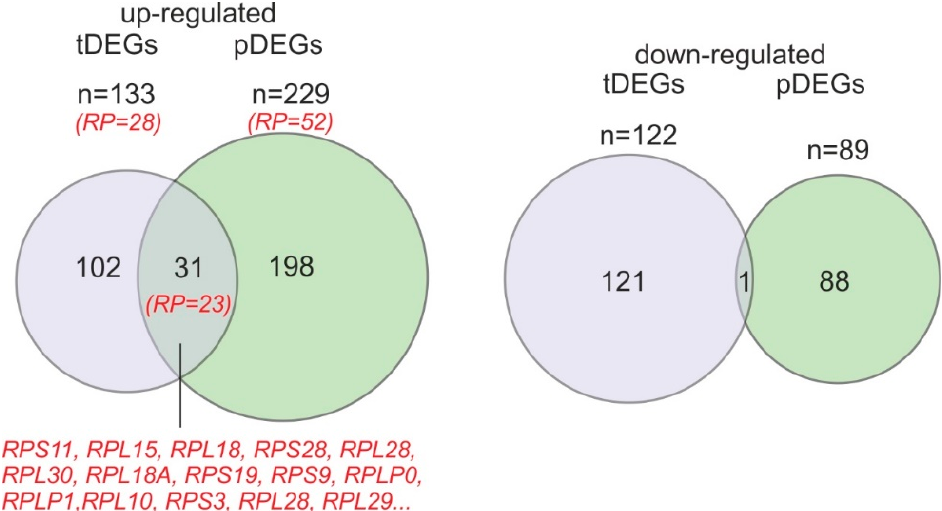
Figure 4. Venn diagrams showing the overlap of up-regulated and down-regulated tDEGs and pDEGs. Ribosomal protein genes are designated in red.